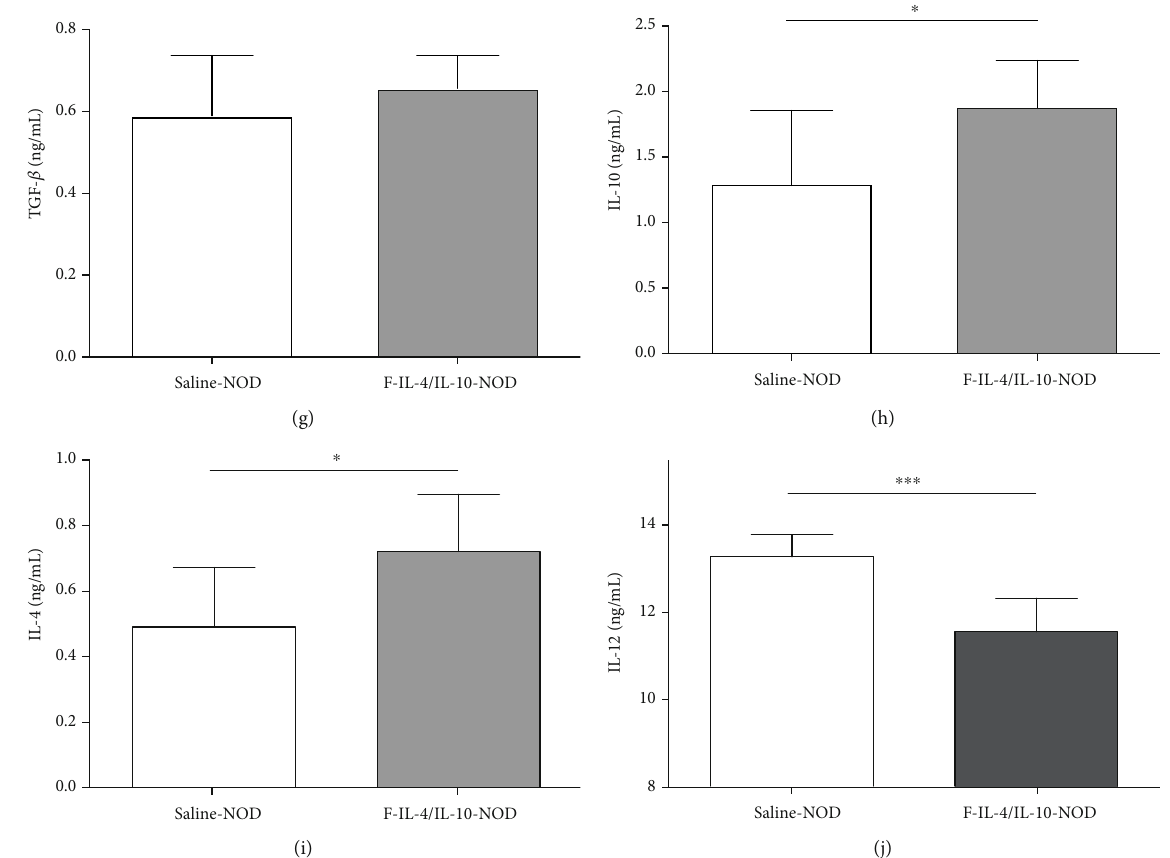
Figure 5: Pancreatic cytokine levels of STZ-induced C57BL/6 mice and NOD mice, which were both treated with oral bacterial administration. After the experimental period, the levels of IL-2, TGF- β , IL-10, IL-4, and IL-12 were analyzed in pancreatic homogenates from STZ model mice ((a – e), respectively; n = 18 ) and NOD mice ((f – j), respectively; n = 12 ). – : negative control; VC: vehicle control;